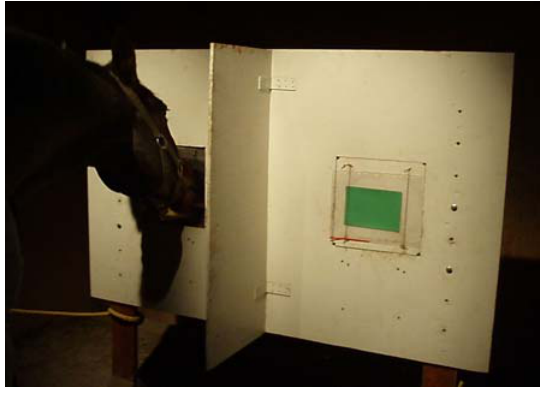
Figure 2. The dual choice apparatus wall. The door presenting the rewarding stimuli is unlocked and enables the horse to reach the pieces of carrots behind the door.